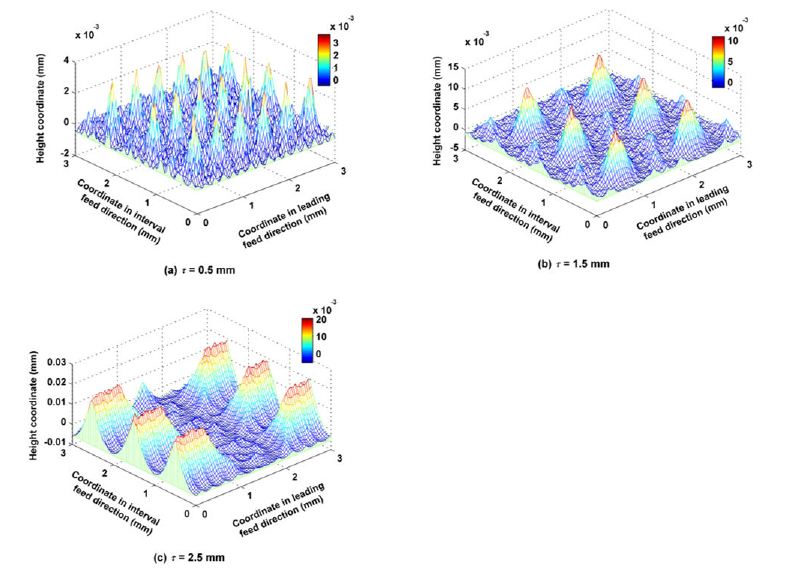
Figure 14. Ball-end milling micro surface topography comparisons among different pitches of the trochoid.